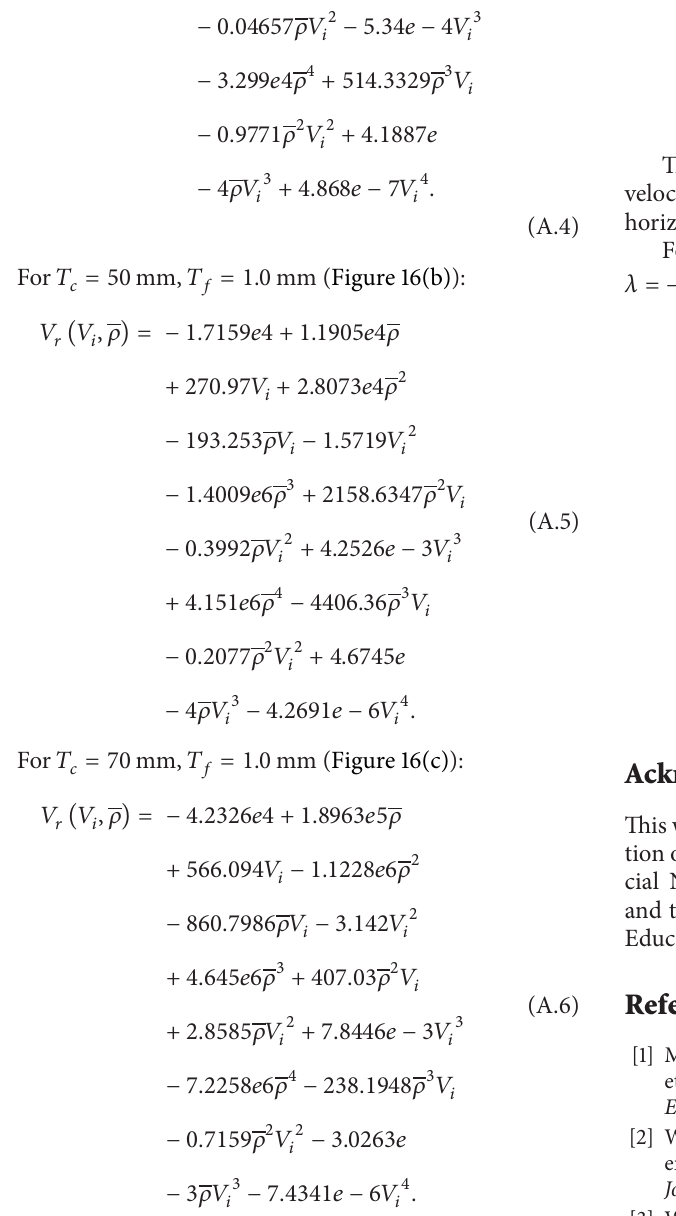
The quartic polynomial functions of projectile residual velocity 𝑉 𝑟 with respect to impact velocity 𝑉 𝑖 and unit cell angle 𝜆 in this study are provided